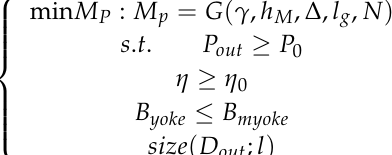
Figure 13. Objective function deriving block diagram.